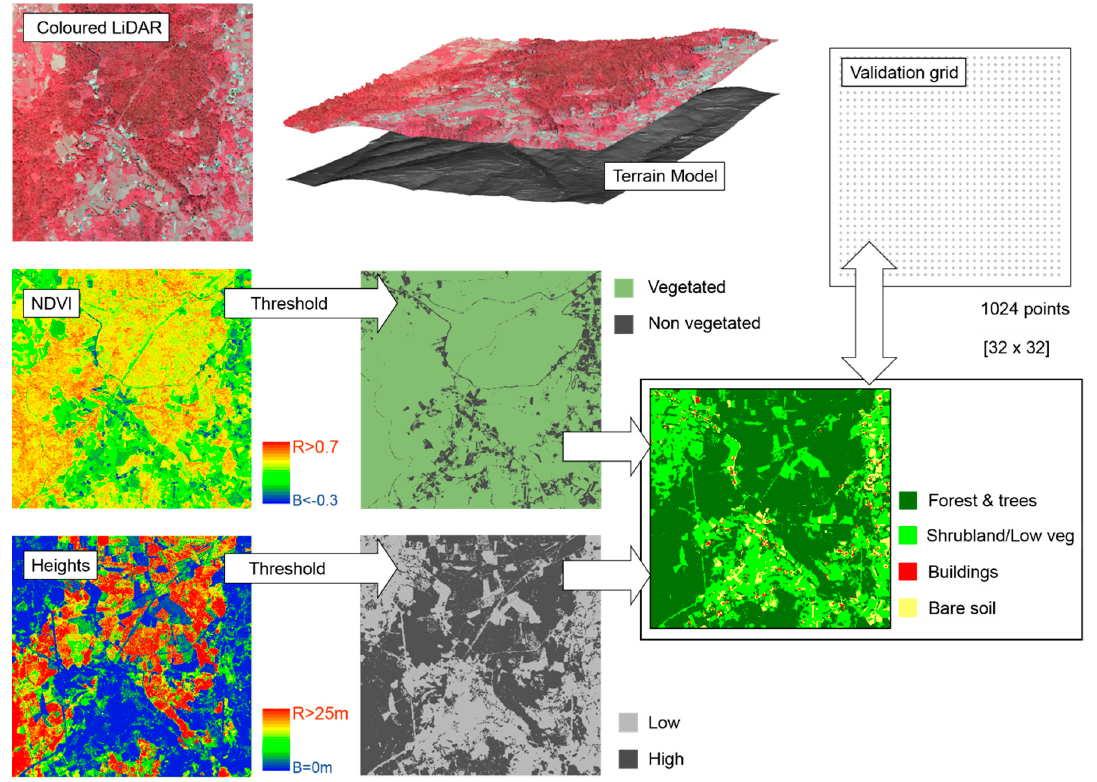
Figure 2. Workflow of the main stages of the proposed method on a 2 x 2 km tile from PNOA (National Air Orthophotography Programme in Spain).